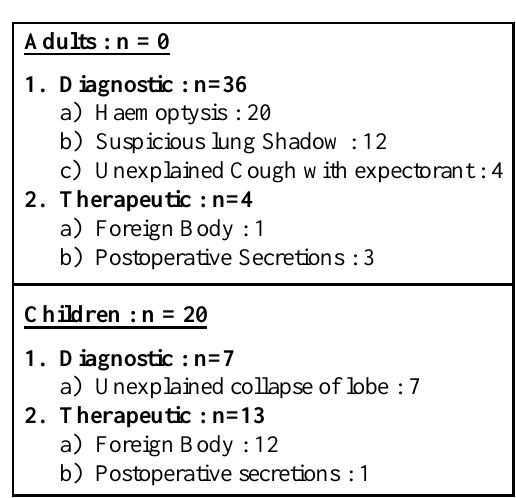
Table II : Indications of